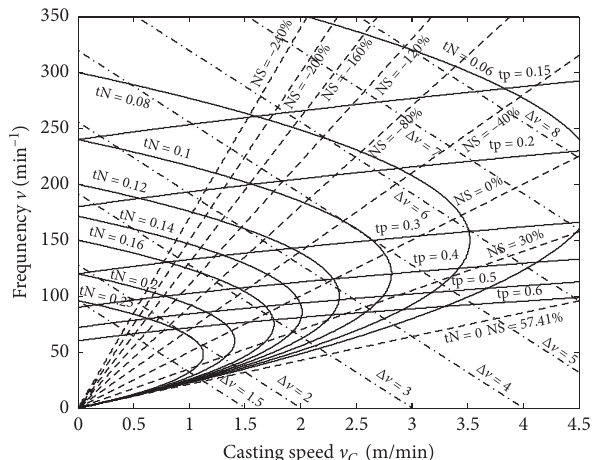
Figure 3: Acceleration curves with h � 4mm, f � 2Hz, and α � 30%.